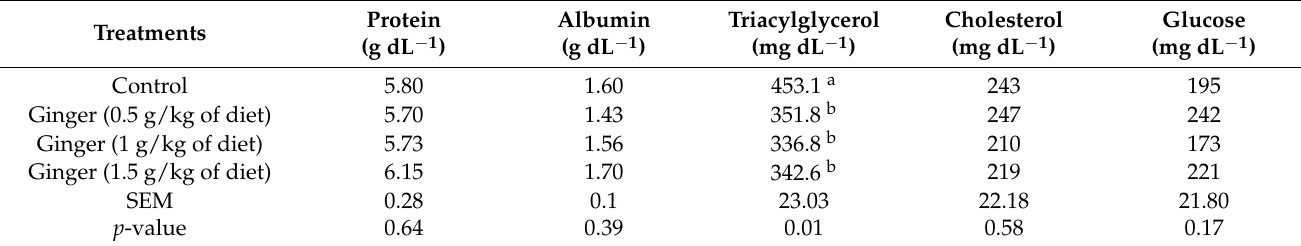
Different letters ( a or b ) after the means within a column indicate significant differences among treatments ( p < 0.05).